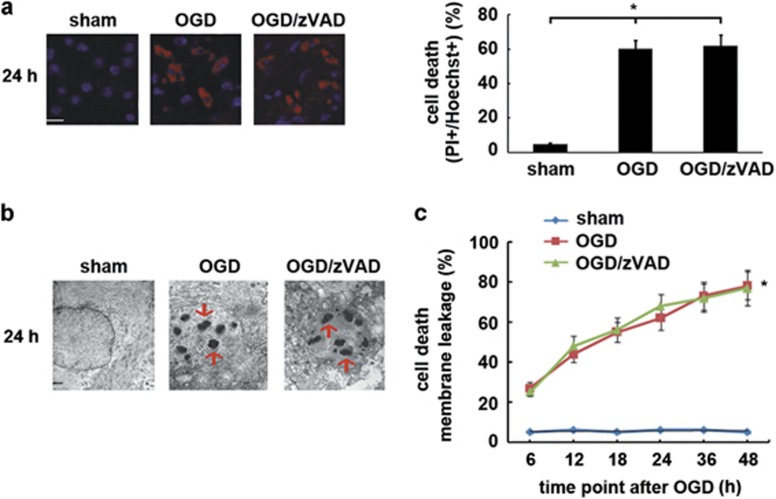
Necroptosis is induced in OPCs following OGD/zVAD insult. (a) Representative images and quantification of PI-positive OPCs treated with OGD or OGD/zVAD. Photographs were randomly taken from three individual 200 × fields per well 24 h after OGD. There were six wells per experimental condition. The numbers of PI-positive cells are expressed as percentages of Hoechst-positive cells. Data are presented as means ±S.E.M. from three independent experiments (Scale bar=20 μm) (*P<0.05, comparing the OGD or OGD/zVAD group with the sham group). (b) Observation of OPCs 24 h after OGD using electron microscopy revealed a morphological pattern with features of necroptosis. An accumulation of cytoplasmic vacuoles was observed, as seen in classical necrosis, whereas nuclei underwent compaction of chromatin into a few discrete, large clumps, similar to classical apoptosis. This was inconsistent with the formation of numerous smaller, irregular chromatin clumps observed during classical necrosis (Scale bar=2 μm). Arrows indicate large clumps in the nucleus. (c) OPCs death was determined kinetically by measuring released protease activity in culture medium. The data are represented as means±S.E.M. from three independent experiments. N=6 for each group in each experiment (*P<0.05, comparing the OGD or OGD/zVAD group with the sham group)